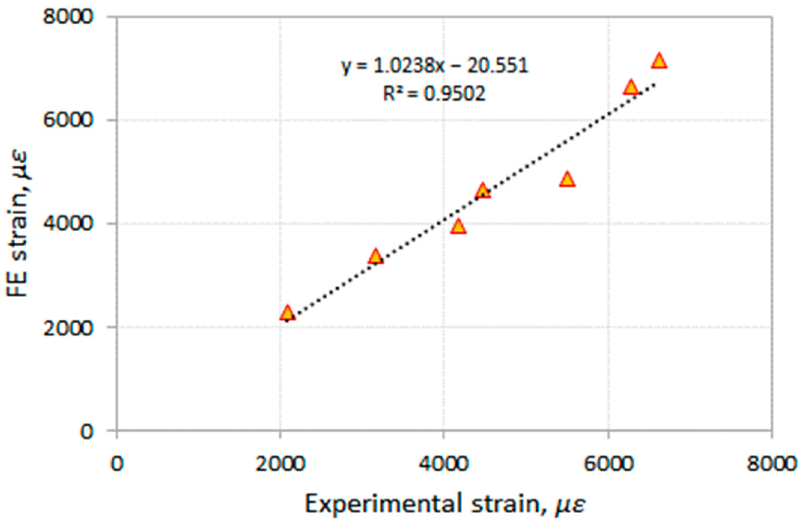
Figure 13. Comparisons of CFRP strains at the middle of the beam obtained from FE analysis and experimental results [47].